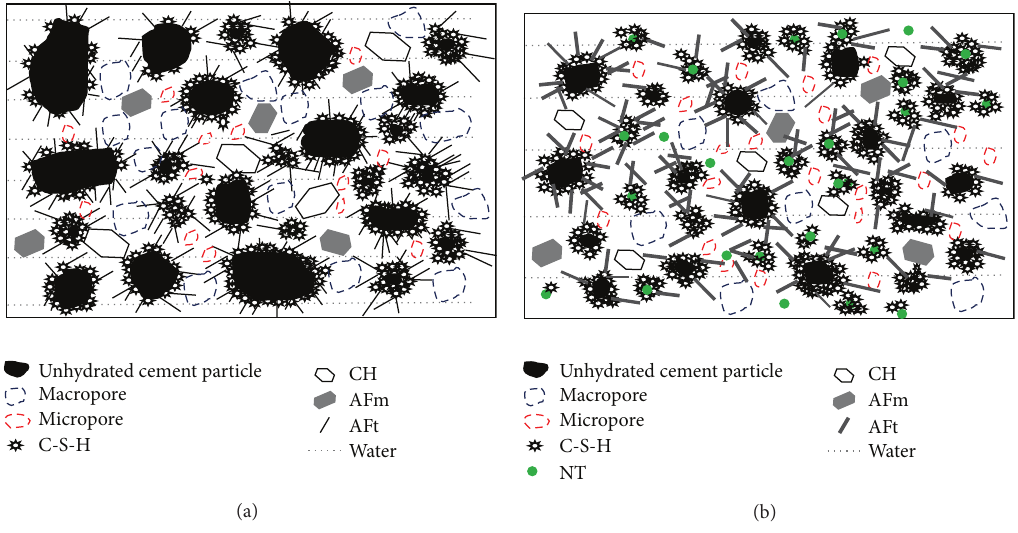
Figure 9: Hydration models of cement mixtures with (a) 0% NT and (b) 3% NT addition at 28